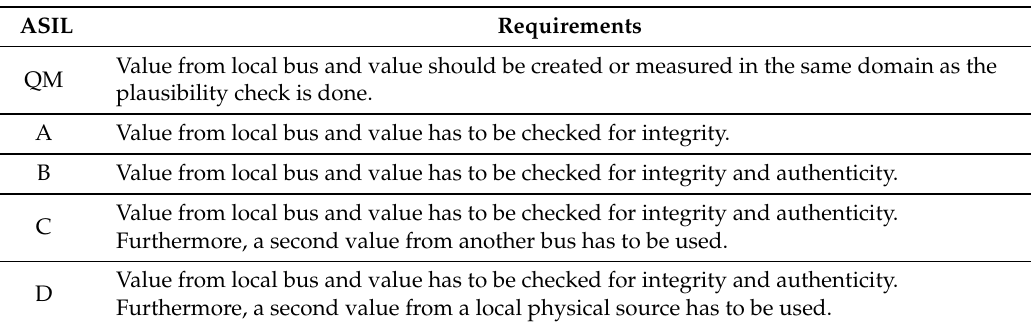
Table 2. Requirements for values used in plausibility check based